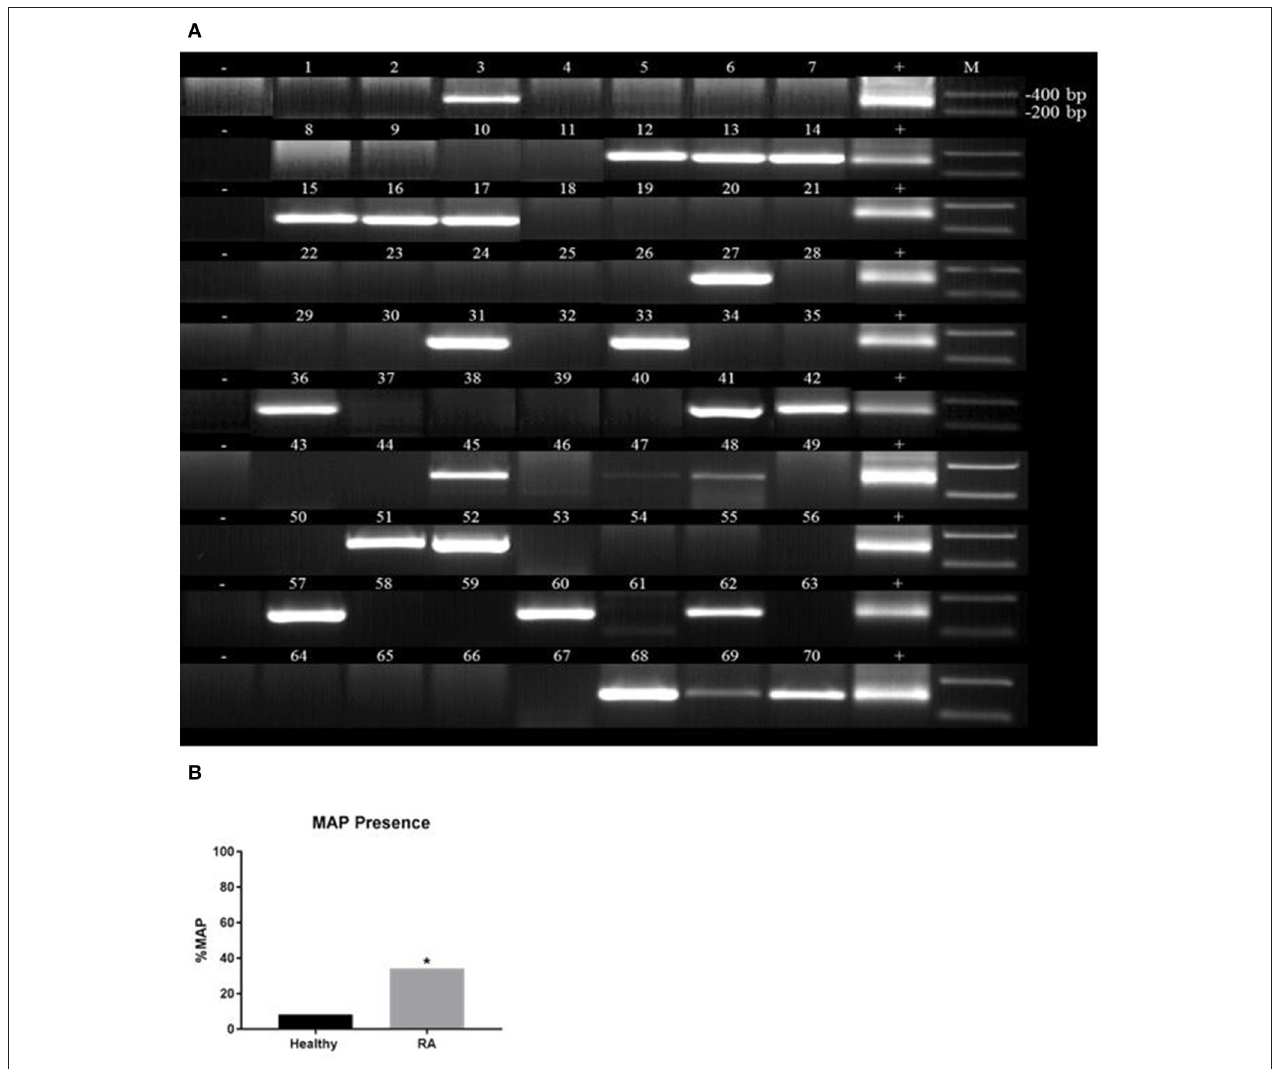
FIGURE 2 | Detection of Mycobacterium avium subspecies paratuberculosis (MAP) in blood samples from RA. Nested PCR was performed on genomic DNA from blood samples from RA subjects (A) and healthy controls (B) . DNA from MAP strain UCF4 was used as a positive control ( + ); a negative control (without DNA template) was also included ( − ). M corresponds with molecular weight marker. * P -values ≤